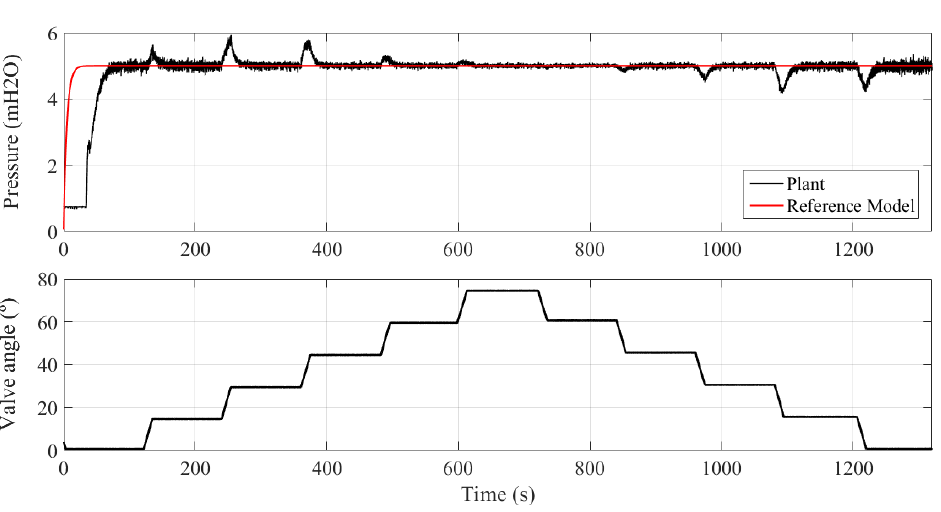
Figure 11. System response under different angles of the VRP CV-1.